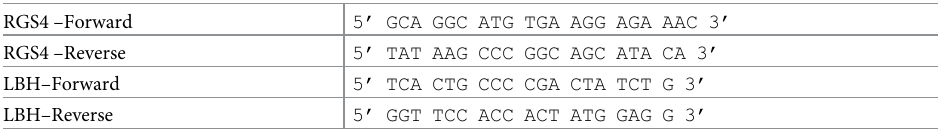
Table 2. Primer sequences for